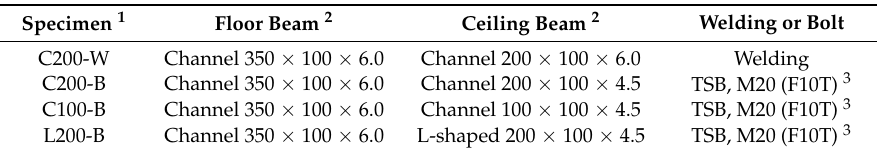
Table 1. Specimens for the cyclic loading